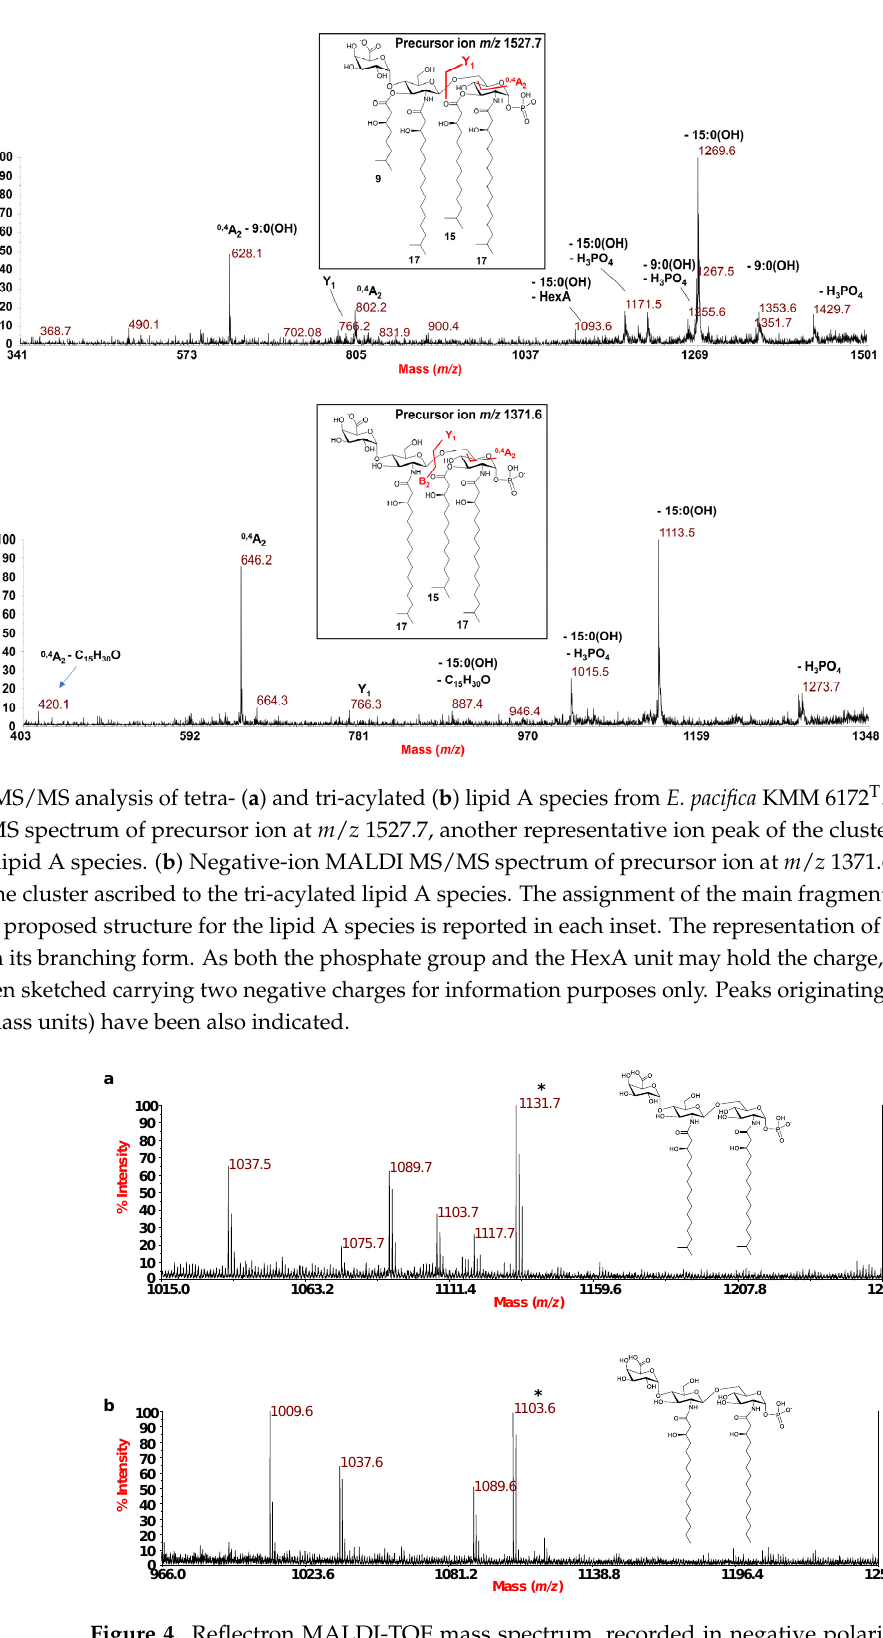
Figure 4. Reflectron MALDI-TOF mass spectrum, recorded in negative polarity, of lipid A from E. pacifica KMM 6172 T ( a ) and E. vietnamensis KMM 6221 T ( b ), after treatment with NH 4 OH. * Indicates the ion peak whose proposed structure is sketched in the inset, where the negative charge held by the phosphate is